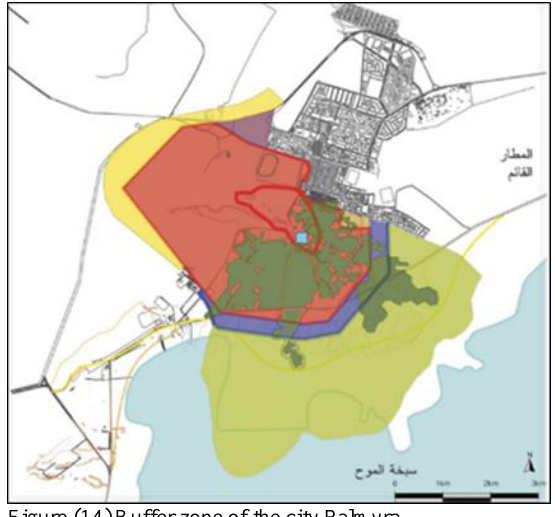
Figure (14) Buffer zone of the city Palmyra Protection zones of the effects of Palmyra in